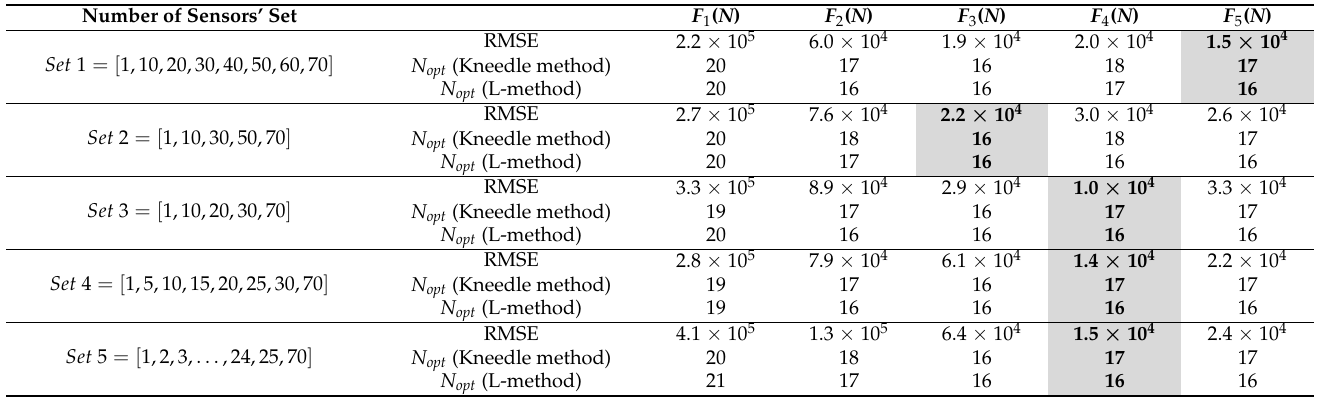
Table 2. Fitted functions’ parameters for Set 1 of hypervolume values. Table 3. RMSE and the optimal number of sensors N opt for the different fitted functions and discrete sets of sensors. The results for the best-fitted function of each discrete set are presented in bold and shaded area. Number of Sensors’ Set